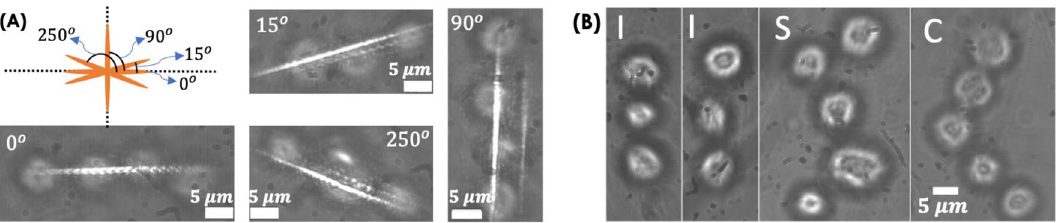
Figure 6. ( A ) Oriented light sheet for patterning at any desired slope. Specifically, trapping and patterning of cells at 0 ◦ , 15 ◦ , 90 ◦ and 250 ◦ in the transverse plane are shown. ( B ) Writing the pattern “IISc” using